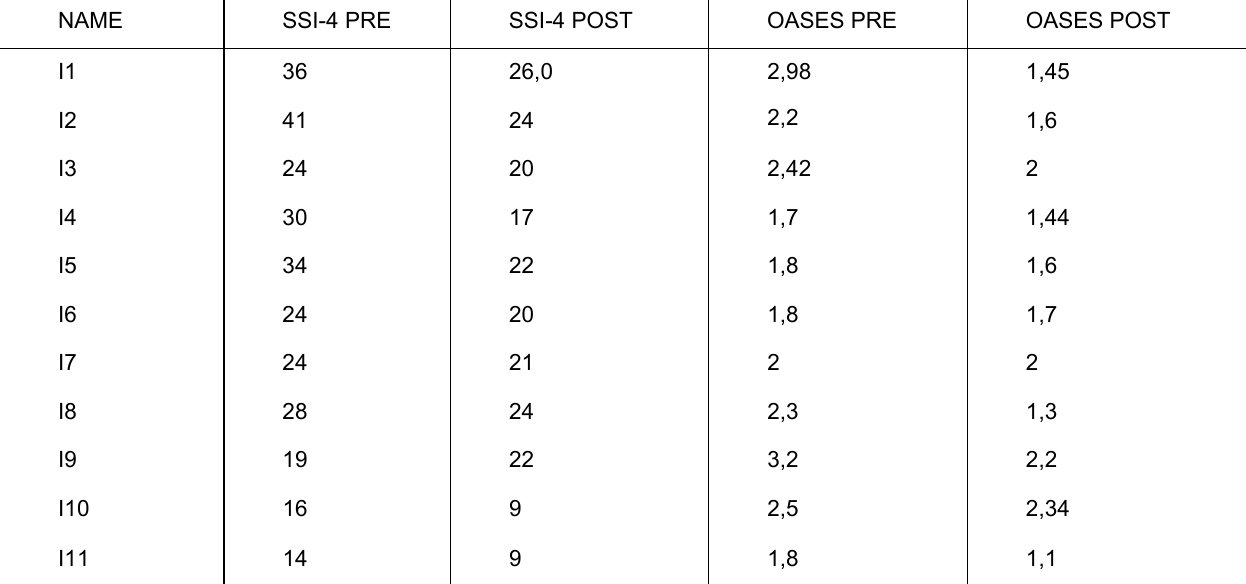
SSI-4 and OASES's Total Scores pre and post treatment for the In-Clinic Group